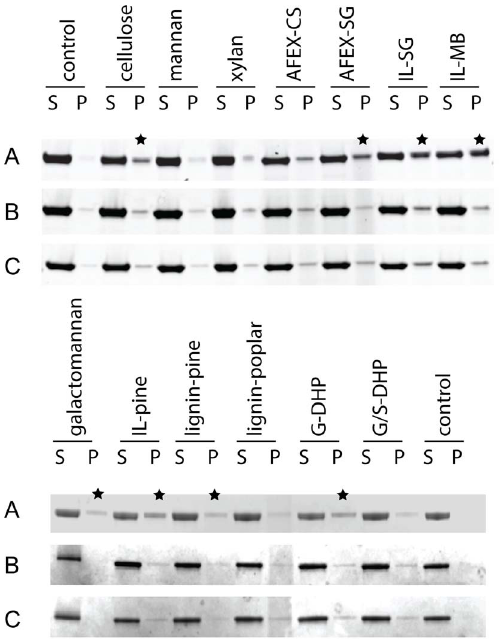
Figure 7. Insoluble substrate binding assays. SACTE_2347 variants were tested for binding to the insoluble substrates indicated using a pull-down format. A, SACTE_2347_FL. B, SACTE_2347_42kDa. C, SACTE_2347_34kDa. The presence of protein in the pellet fraction (P) indicates binding, as the control lane showed each variant was fully soluble in the conditions tested in the absence of an insoluble substrate. Black stars indicate the substrates for which binding was